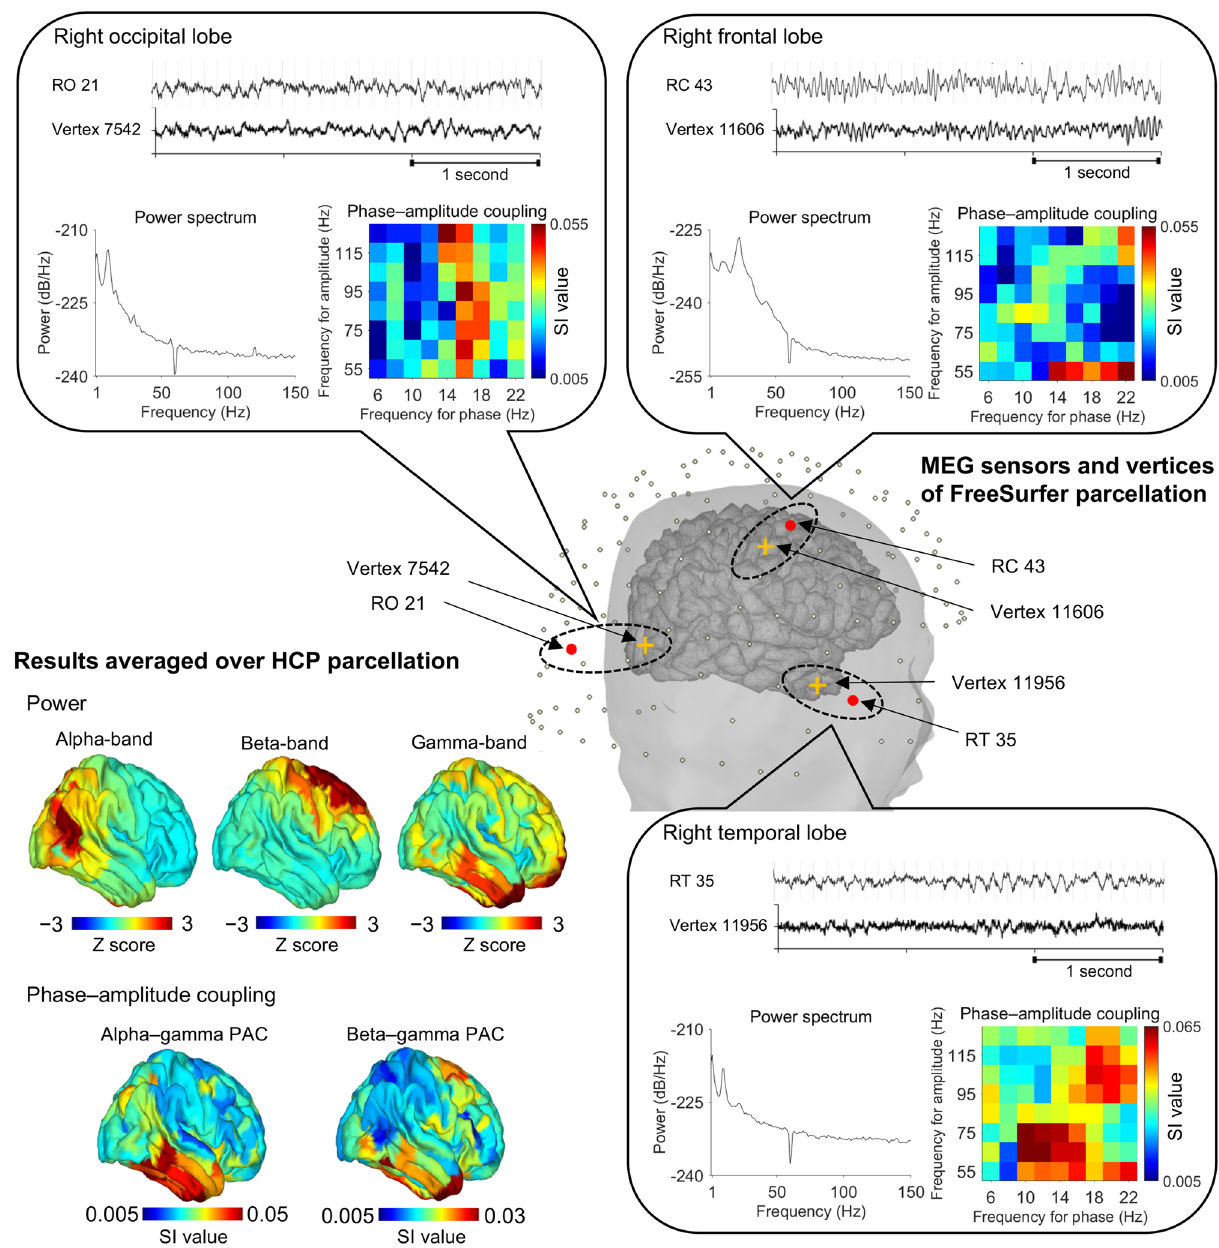
Figure 2. Representative MEG signals. This sample analysis shows the phase-amplitude coupling (PAC) and power calculated from data for patient #21. In the center, the scalp and the extracted cortex are superimposed, with magnetoencephalography (MEG) sensors overlaid. Three cortical vertices (crosses) were selected from FreeSurfer parcellation. The MEG sensors close to them (circles) were also selected. Signals from the selected MEG sensors and estimated cortical currents for the selected vertices are shown. Power spectra and synchronization index (SI) values calculated from each cortical current are plotted. In the SI plots, each phase has a 4-Hz frequency range (that is, “6 Hz” in frequency for phase corresponds to “4–8 Hz”), and each frequency range has a 50-Hz amplitude range (that is, “55 Hz” in frequency for amplitude corresponds to “30–80 Hz”). At the lower left, Z scores for power and SI values calculated on vertices of the right hemisphere are grouped according to Human Connectome Project parcellation, averaged in each cortical area and color-coded on the cortex. This figure was created using Brainstorm (http:// neuro image. usc. edu/ brain storm) and MATLAB R2015b (MathWorks, Natick, Massachusetts,